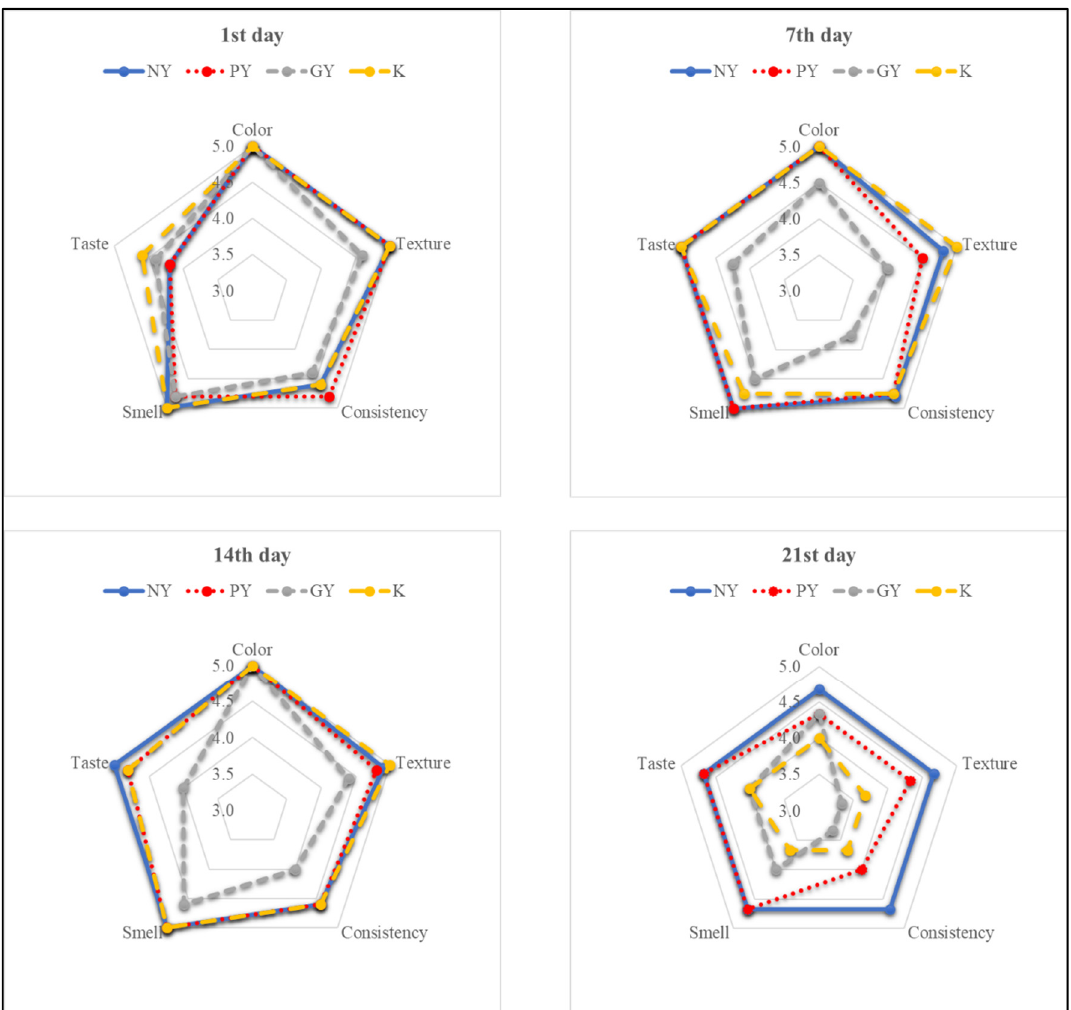
Figure 2. The effects of storage time and the type of fermented beverage on selected organoleptic characteristics of the product. NY—Natural yogurt, PY—Probiotic yogurt, GY—Greek yogurt, and K—Kefir.